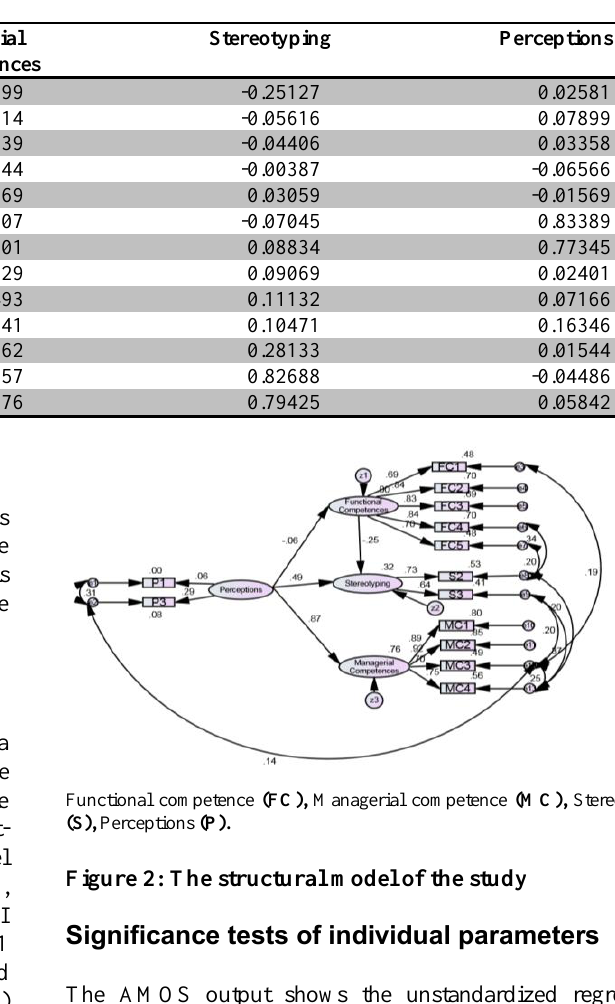
The AMOS output shows the unstandardized regression coefficients. Each unstandardized regression coefficient represents the amount of change in the dependent variable for each unit change in the variable predicting it. The output also shows the unstandardized estimate, its standard error (S.E.) and the estimate divided by the standard error (Critical Ratio – C.R). The critical ratio is > 1.96 demonstrating a significant path at the 0.05 level of significance. Also, under the p-value column, three asterisks (***) indicated that an item is significant at p < 0.001. It is evident from the results that all the paths (shown in colour) are not significant since their critical ratios are less than 1.96 and their p-values are greater than 0.05 level of significance. Then the remaining paths (not shown in colour) are all significant since their critical ratios are greater than 1.96 and their p-values are lesser than 0.05 level of significance (see Table